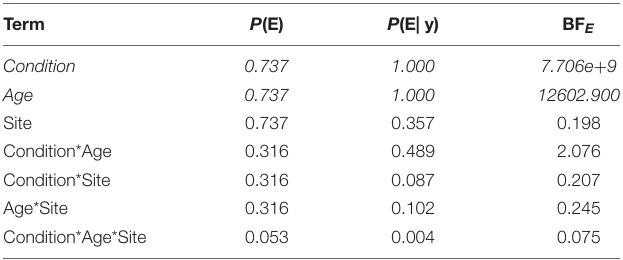
TABLE 5 | Results for all included terms in the Bayesian model comparison for recognition memory performance (difference hits –